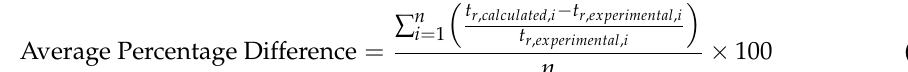
for all C for all data. 𝐶𝐶∗ 𝑄𝑄